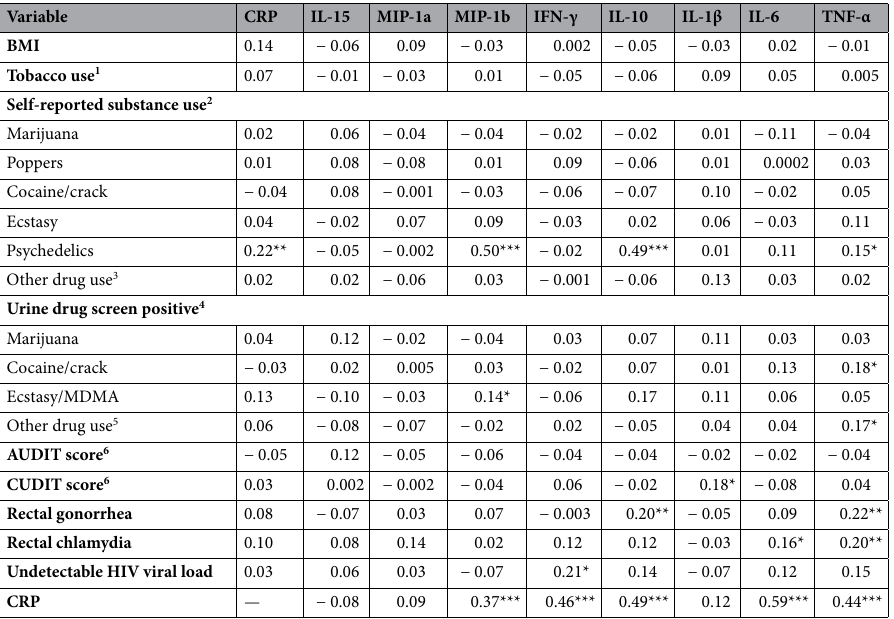
Table 2. Correlations between inflammatory cytokines, CRP, and various substances among persons living with HIV, RADAR, Chicago, 2015–2017. *p < 0.05; **p < 0.01; ***p < 0.001. 1 In the past 30 days. 2 In the past six months, only those self-reported use ≥ 4%. 3 Substance with < 4% self-reported use in the sample: methamphetamines, synthetic marijuana, ketamine, GHB, inhalants, heroin. 4 Note: urine drug screens unavailable for poppers and psychedelics. 5 Other urine drug screens include: benzodiazepines, amphetamines, methamphetamines, opiates. 6 Based on the Alcohol Use Disorders Identification Test (AUDIT) and Cannabis Use Disorders Identification Test (CUDIT) scoring methods; higher score indicates higher risk alcohol